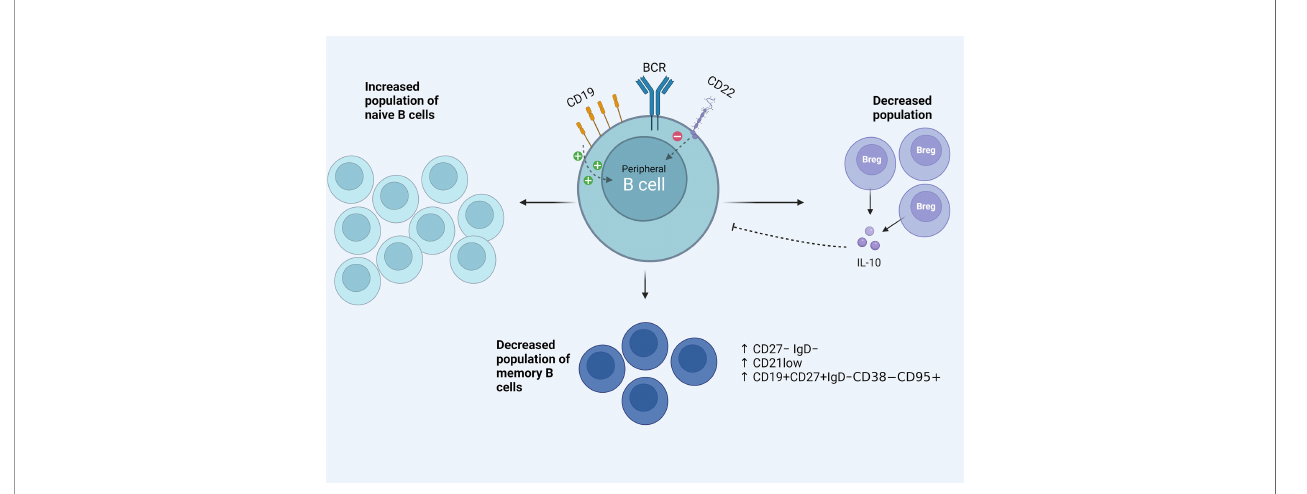
FIGURE 1 | Aspects of the activated B cell phenotype in the peripheral blood of patients with SSc. Signaling defects including CD19/CD22 imbalance, increased effector B cell phenotypes among the memory B cell compartment and decreased B regulatory population and